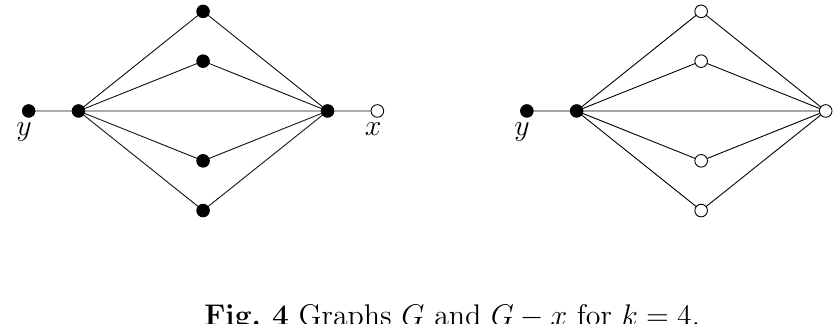
Fig. 4 Graphs G and G − x for k =